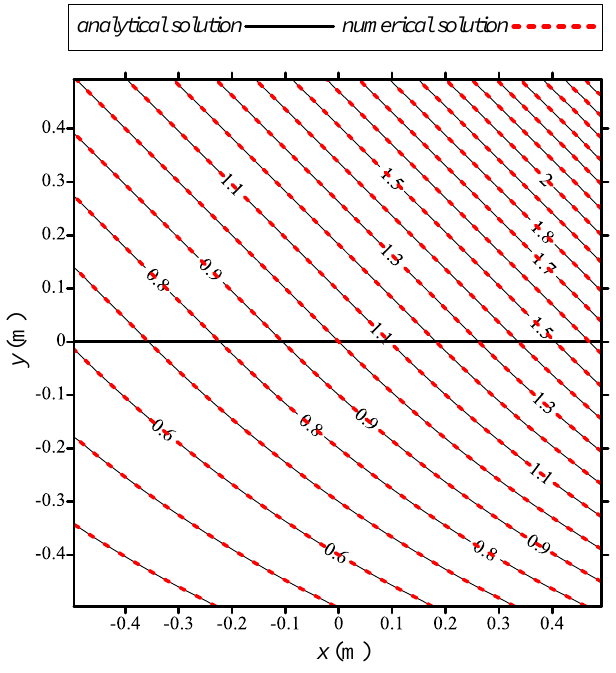
Figure 18. Results comparison with the exact